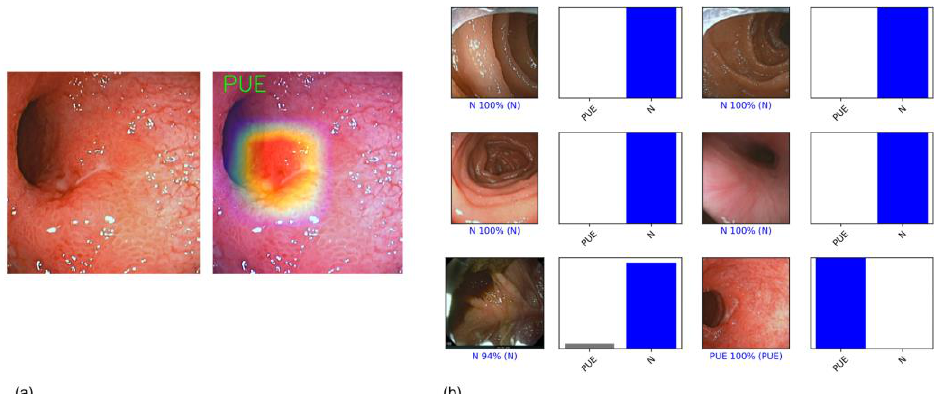
Figure 2. ( a ) Example of a heatmap highlighting CNN’s detection of an ulcerative; ( b ) output obtained from CNN application. Each bar represents the probability estimated by the algorithm of being considered normal and a probability of having ulceration or erosion. Each frame was classified in one of the aforementioned categories considering the one with higher probability. The corresponding evaluation provided by the three expert endoscopists, which was considered the gold standard, is written between parentheses. In the case of a correct prediction, the bar was painted blue. In the case of an incorrect one, the bar was painted red.